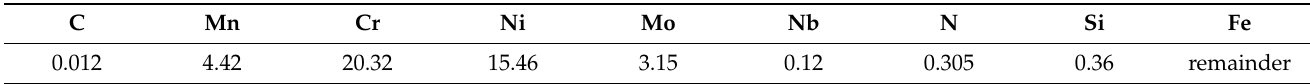
Table 1. The chemical composition (in weight %) of 1.3964 stainless